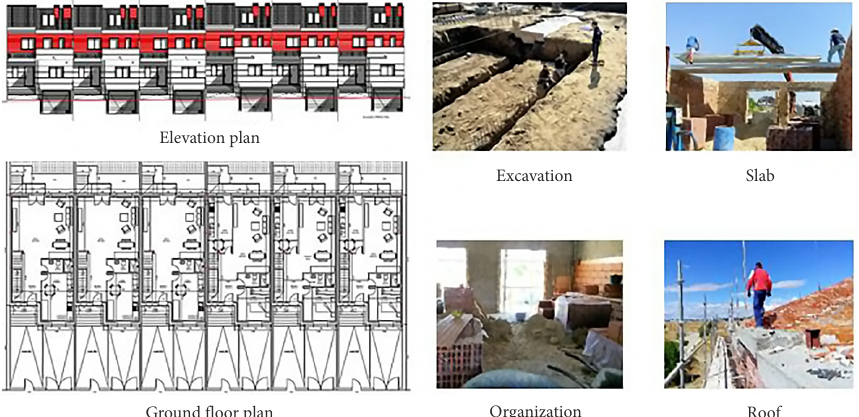
Figure 2. Plans of the houses. Elevations and Ground Floor.